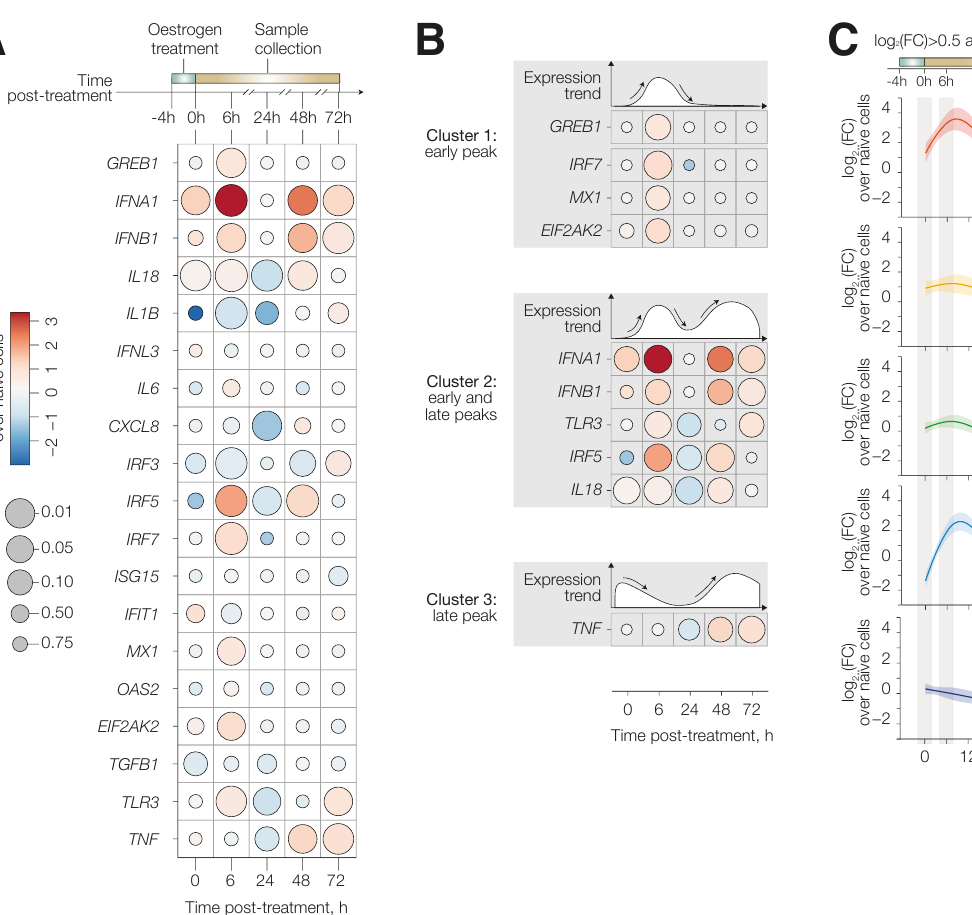
Figure 2. Gene expression profile of E2-treated cells. HuH7 cells were treated with 17 β -oestradiol or DMSO (naïve cells) for 4 h and then incubated in fresh media. Gene expression was evaluated at different time points as indicated. The mRNA levels are reported as log 2 (FC) normalised to naïve cells. ( A ) Bubble plot of the mRNA fold-change from 18 innate immune genes in oestrogen-treated cells. Data represent the mean of at least 3 independent experiments with 2 biological replicates. Statistical significance was evaluated by multiple t -tests with Bonferroni correction. ( B ) Grouping of the three distinct clusters based on their expression pattern: early ( top ), early and late ( middle ) and late ( bottom ). ( C ) Time-course gene expression of the five genes with log 2 (FC) > 0.5 and p < 0.05 for at least two time points. In each graph, the line represents the gene expression trend based on mean values for each time point. Shading shows